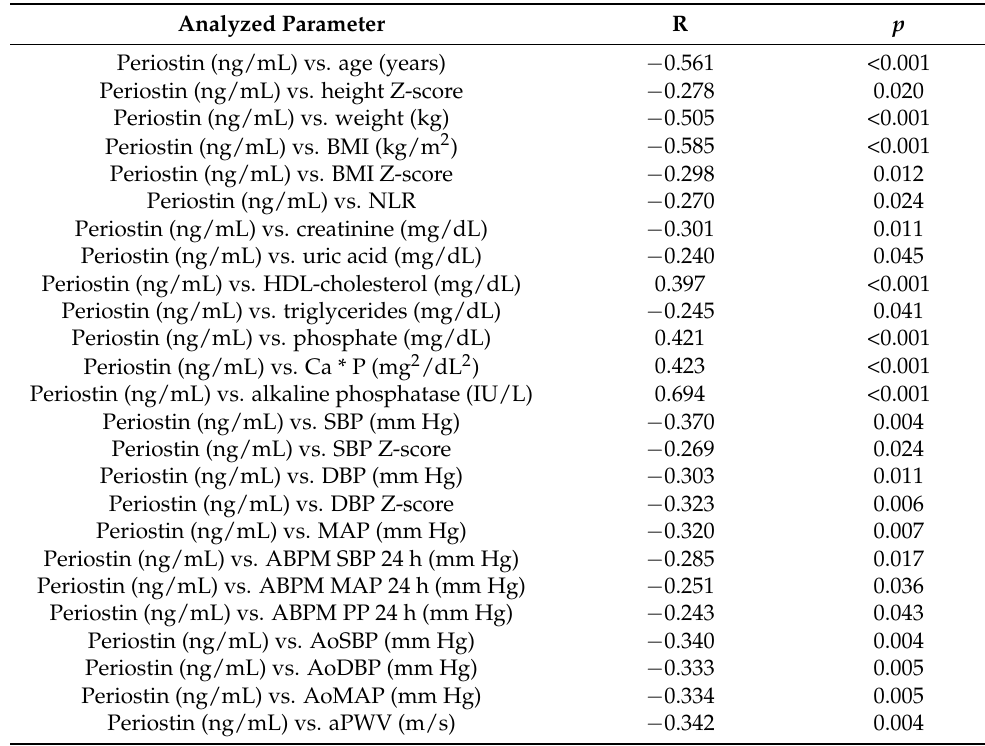
Table 2. Correlations of periostin concentration with clinical, biochemical parameters, blood pressure, and arterial damage parameters in 70 studied